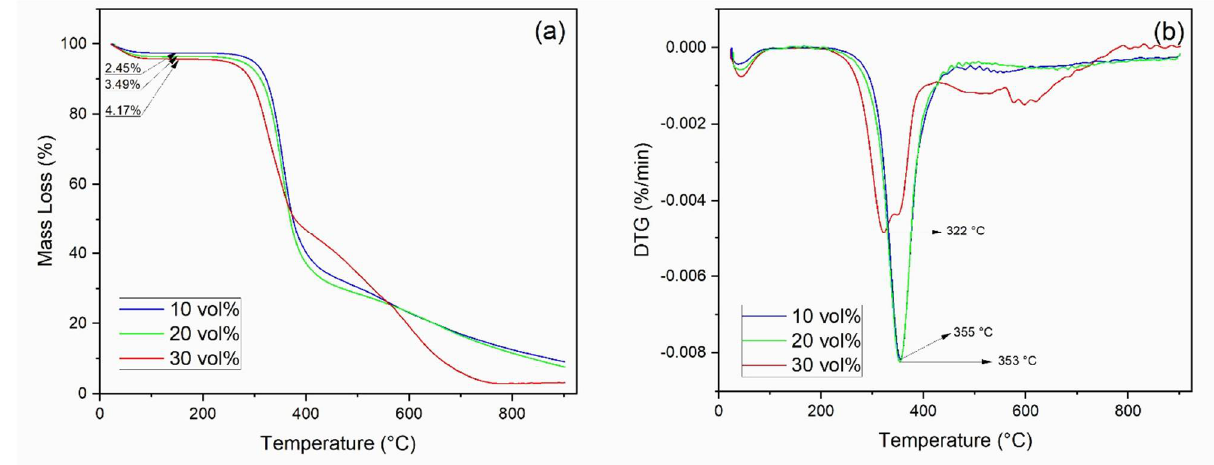
Figure 5. (a) TG curves of composites; (b) DTG curves of composites.